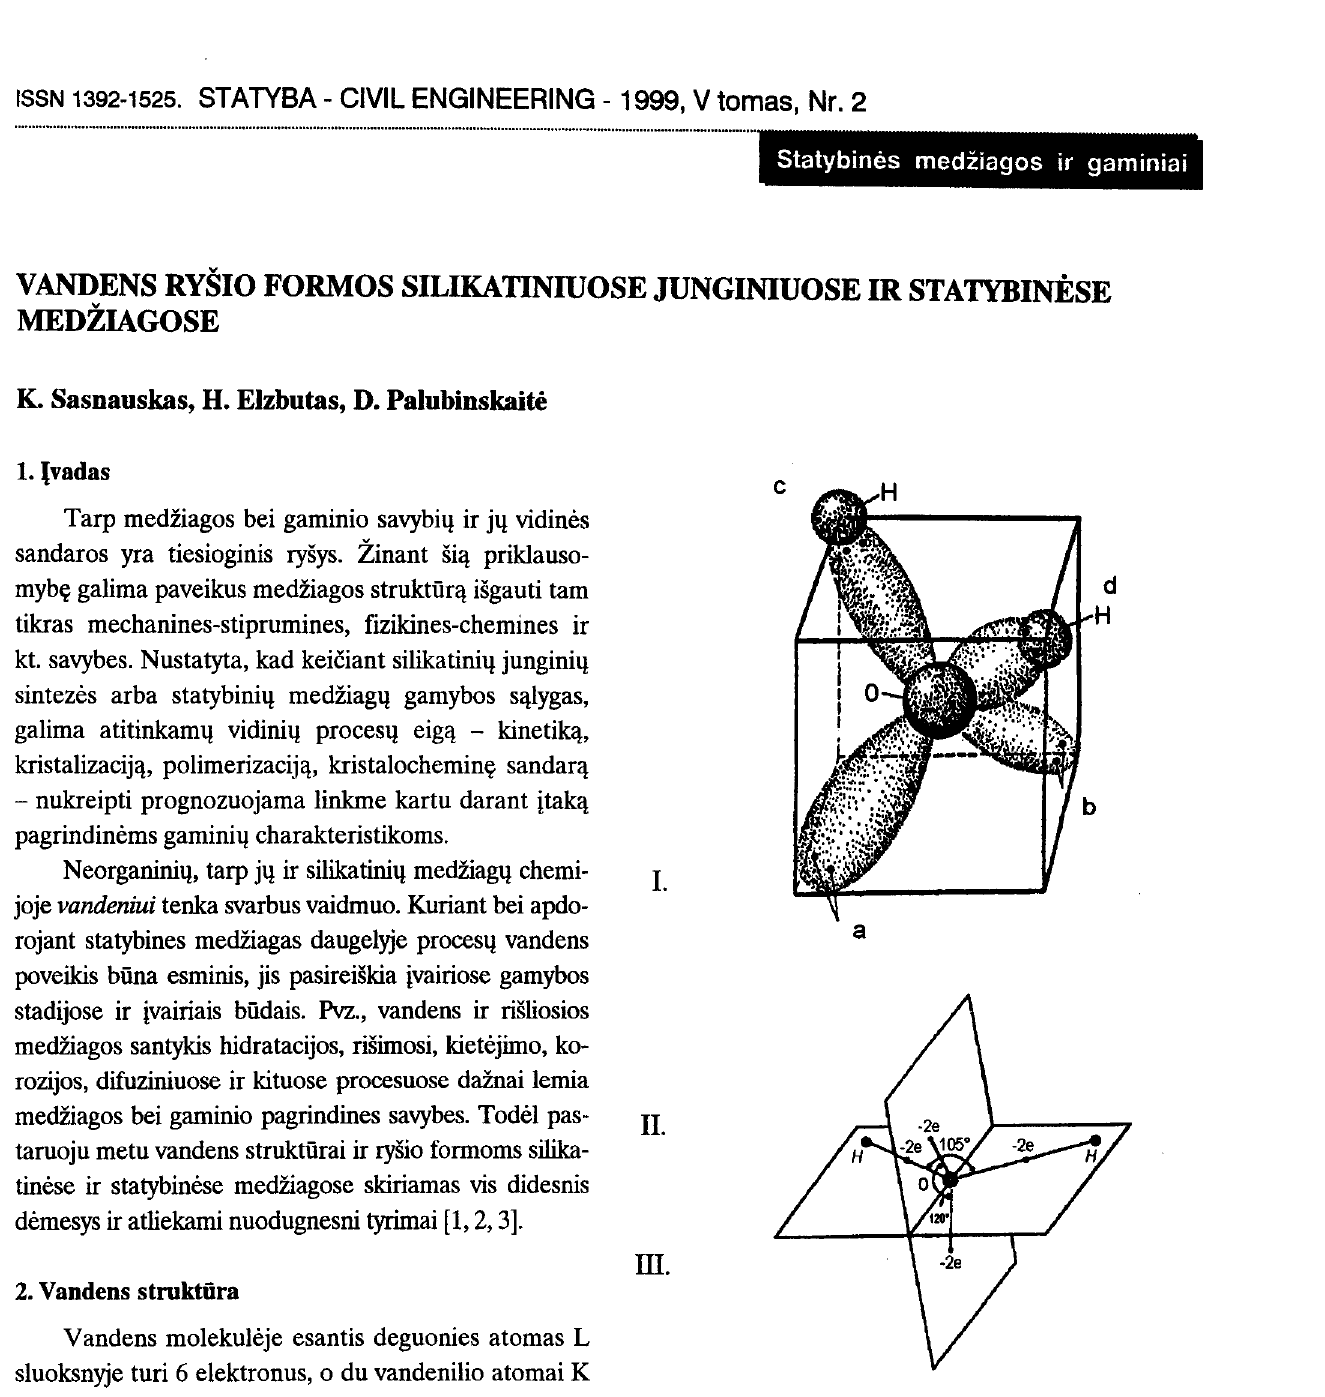
·0,32e Elektronq pasiskirstymas vandens molekuleje: II - pagal Fig 1. I- Tetrahedral structural model of a water molecule. Distribution of electrons in a water molecule: II - according to Dunkan and Pople (1953), Ill- according to Rawlinson (1951)